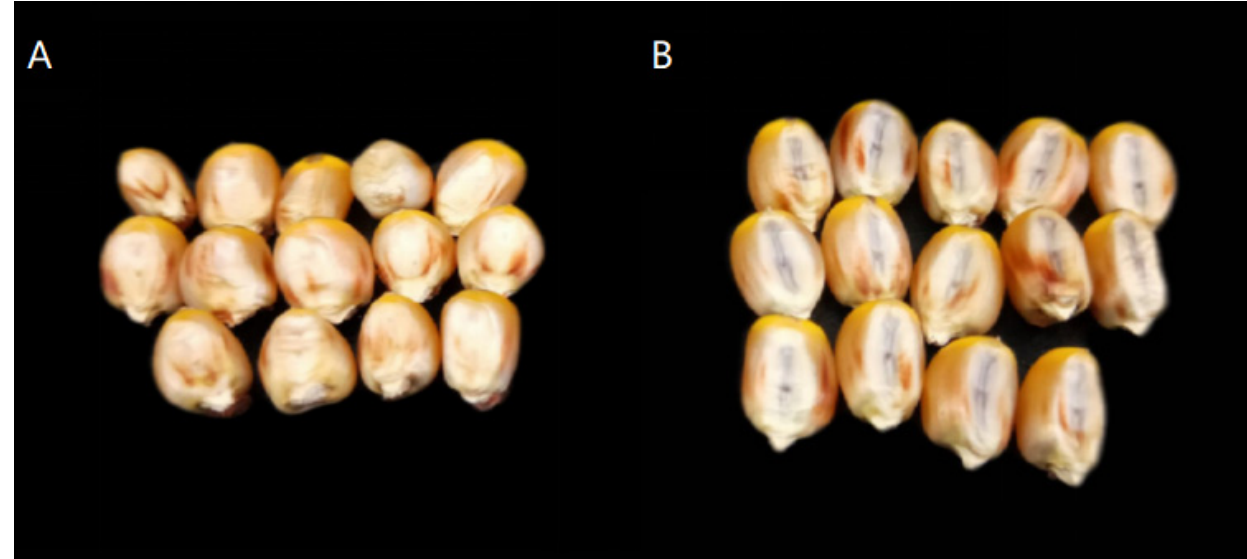
Figure 1. Two different types of hybrid induction kernels: ( A ) haploid kernels; ( B ) diploid kernels.